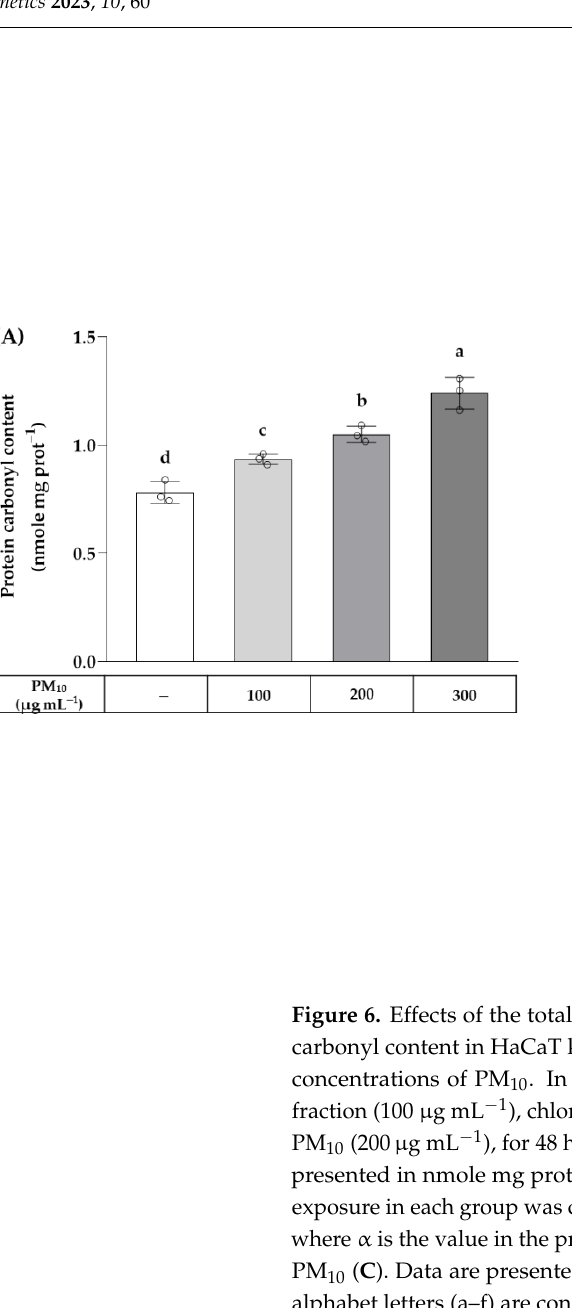
extract, BA fraction, chlorogenic acid, or NAC. PM 10 and other test materials had little effect on the mRNA expression levels of PTGES1 and PTGES2